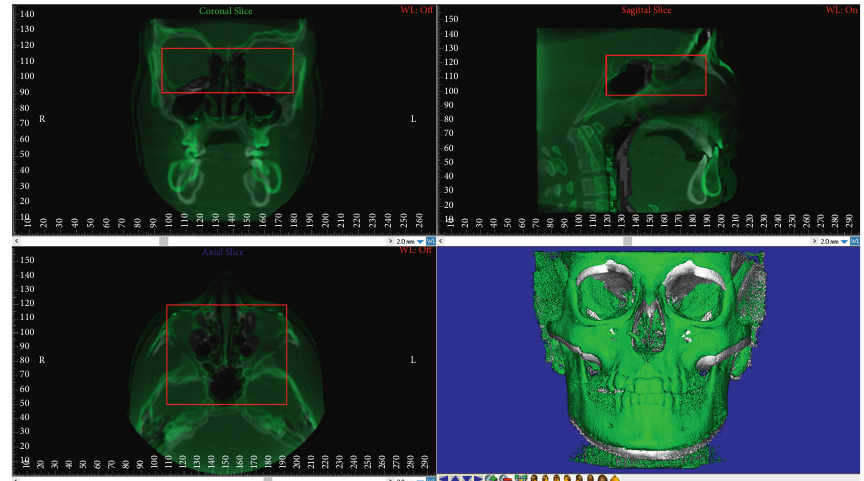
Figure 4: Voxel-based superimposition: selection of the Volume of Interest (VOI) on the cranial base structure of T0-CBCT (before treatment) and registration of the T1-CBCT